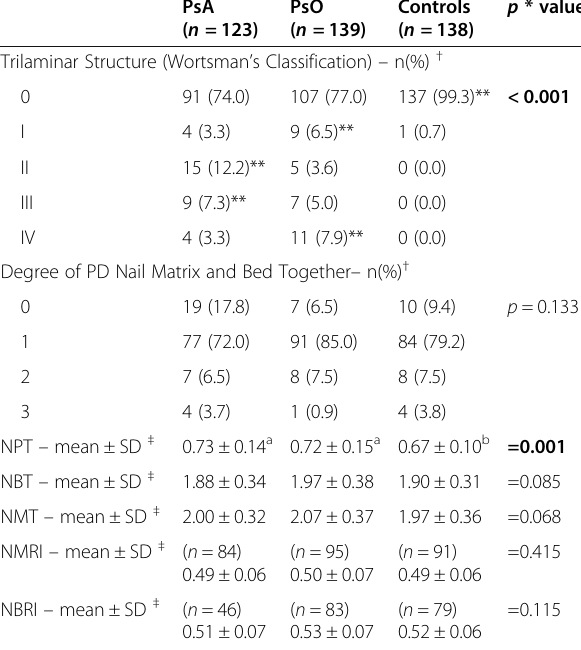
Table 2 Prevalences and means of outcomes among groups Table 3 Linear regression analysis of quantitative